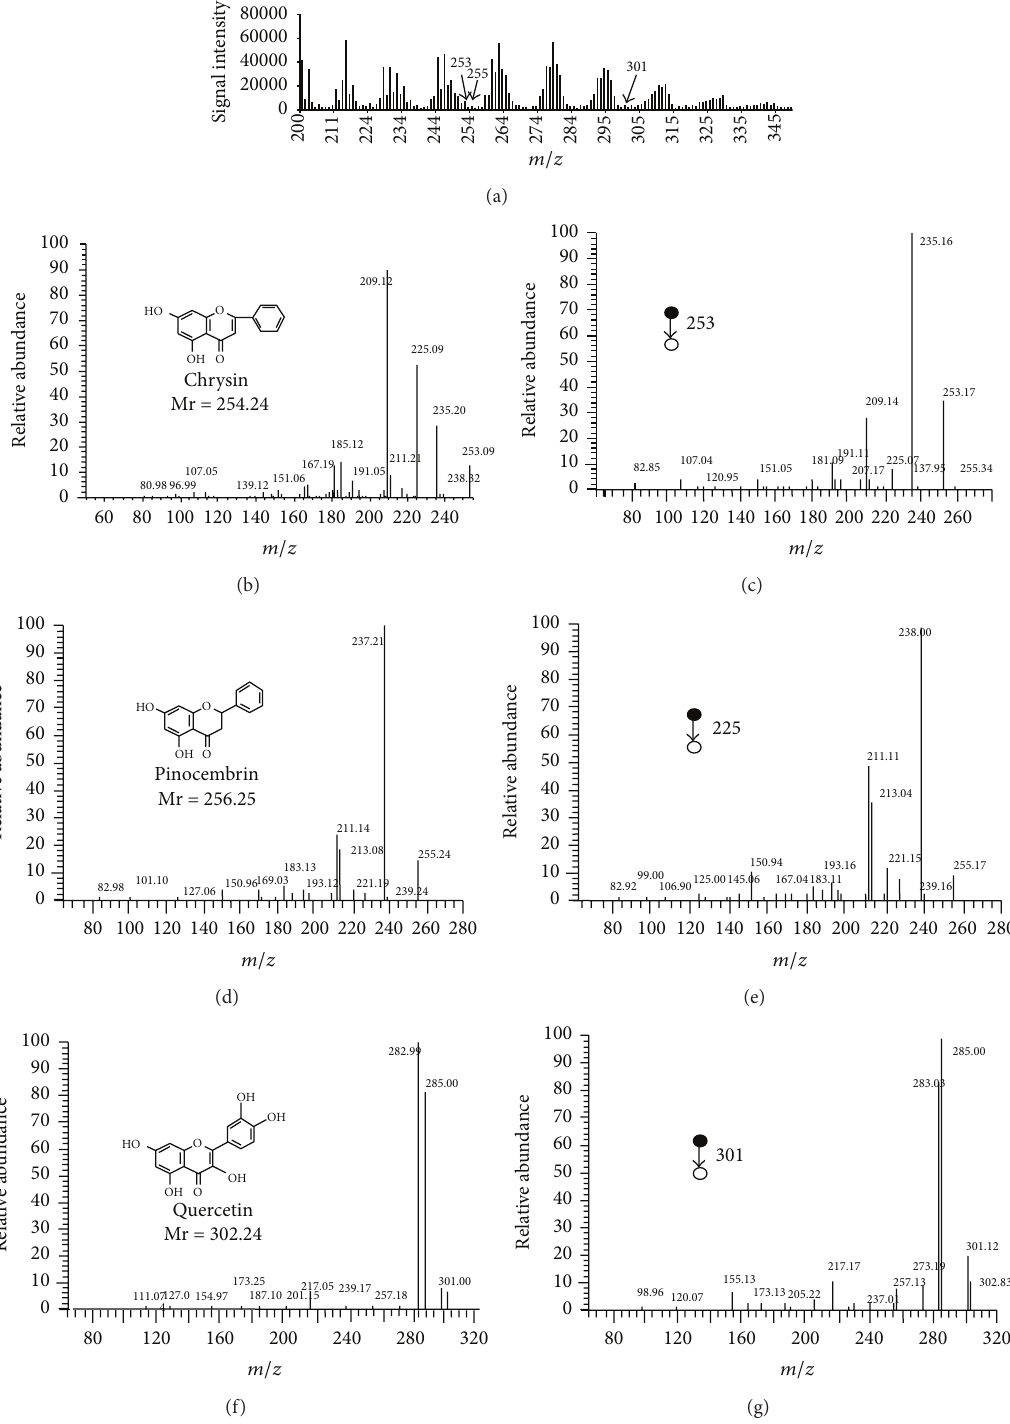
Figure 3: The MS 2 spectra of propolis. (a) MS spectrum of propolis sample 1 (HLJ) and 253, 255, and 301 m/z are indicated by arrows. (b), (d), and (f), MS 2 spectra of reference standards of quercetin (b), chrysin (d), and pinocembrin (f). (c), (e), and (g), MS 2 spectra of 253 m/z (c), 255 (e), and 301 (g) in MS spectrum of propolis sample 1